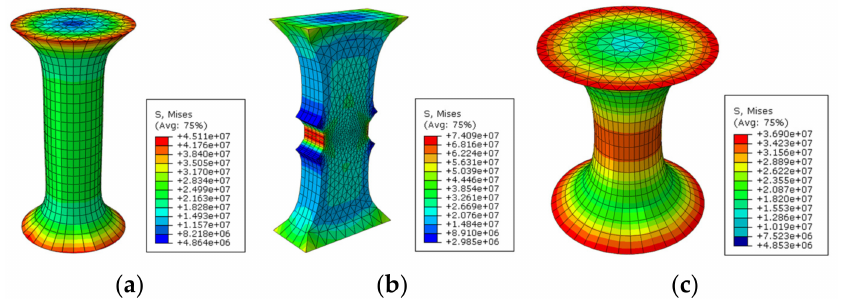
Figure 5. Effects of thermal load on asphalt mixture response direct tensile test configurations. ( a ) Cylindrical geometry; ( b ) double-notched geometry; and ( c ) dog-bone